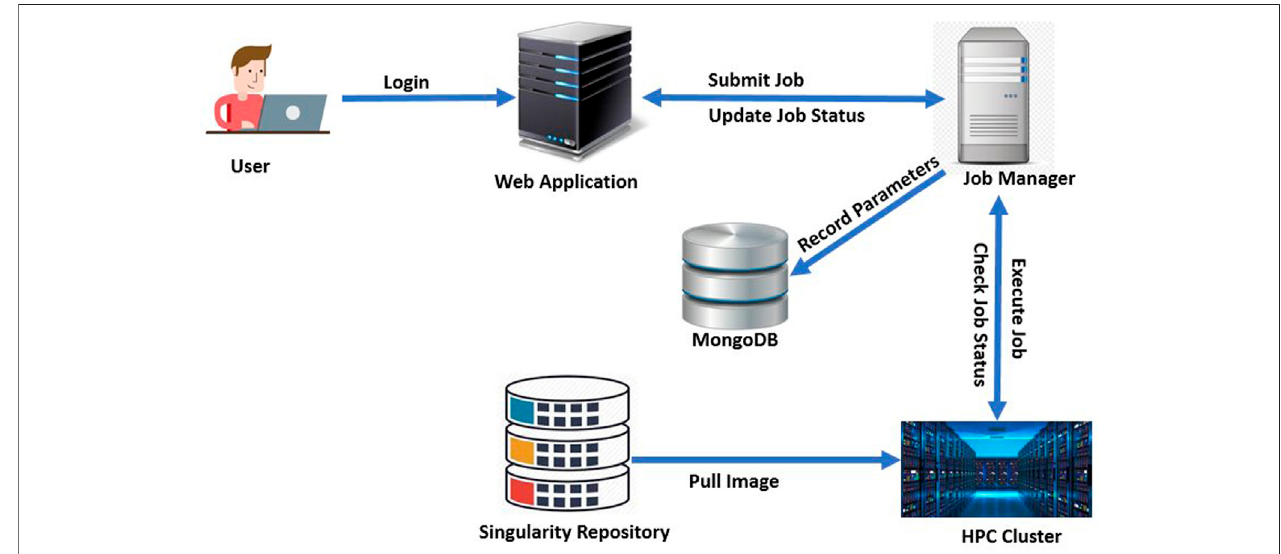
FIGURE 11 | Architecture of DeepBrainIPP: DeepBrainIPP consists of four modules [web Application, job manager, singularity repository and High Performance Computing Cluster